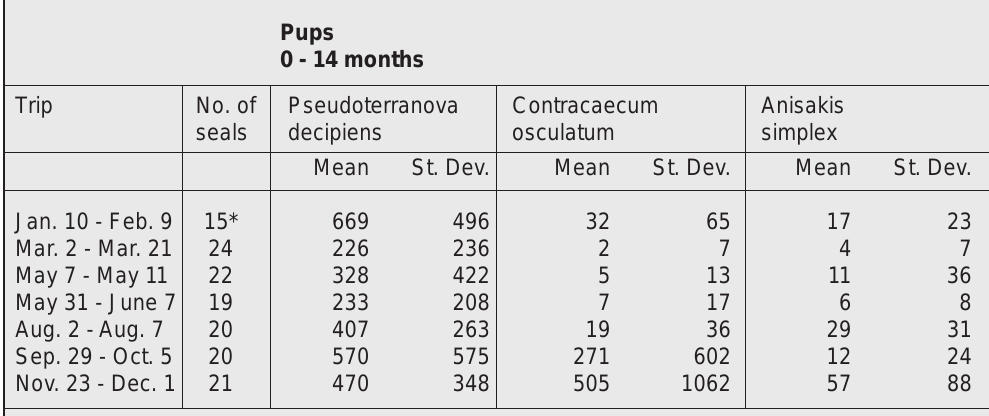
Table 1. Mean abundances of nematodes, by life history stage, in the stomachs of grey seals du- ring each trip period on Sable Island.